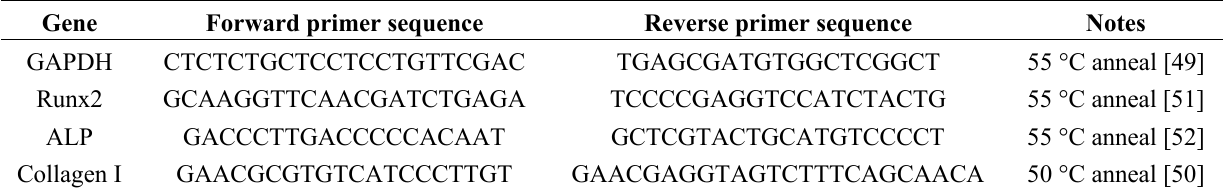
Table 1. RT-PCR primer sequences for glyceraldehyde phosphate dehydrogenase (GAPDH), Runx2, alkaline phosphatase (ALP), and collagen I. Gene Forward primer sequence Reverse primer sequence